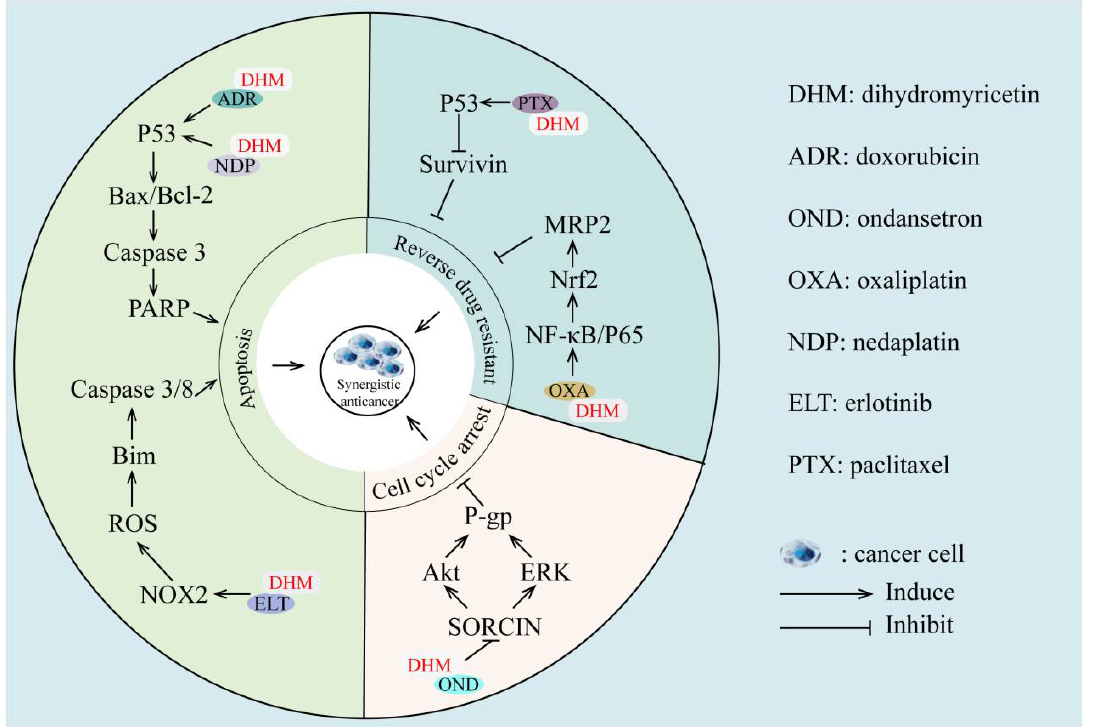
Figure 2. Synergistic effects and mechanisms of DHM combined with different chemotherapeutic drugs. DHM is used in combination with a variety of drugs (such as ADR, OND, OXA, NDP, ELT, and PTX) to play a synergistic anticancer effect by increasing the sensitivity of cancer cells to drugs, reversing multidrug resistance, and inducing cancer cell